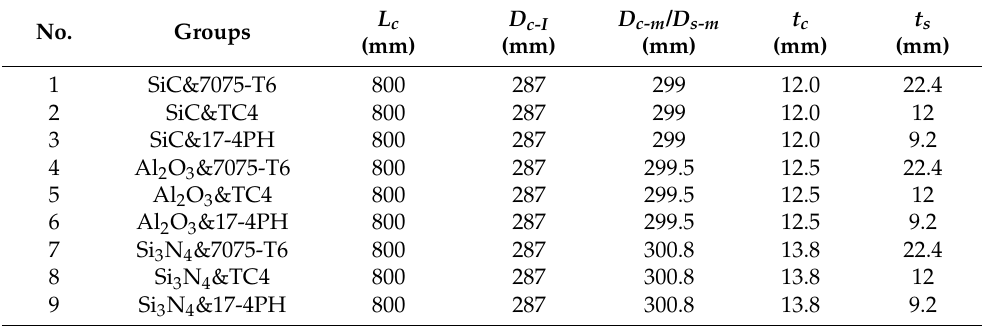
Table 2. Preliminary design dimensions of the nine groups of ceramic pressure housings.